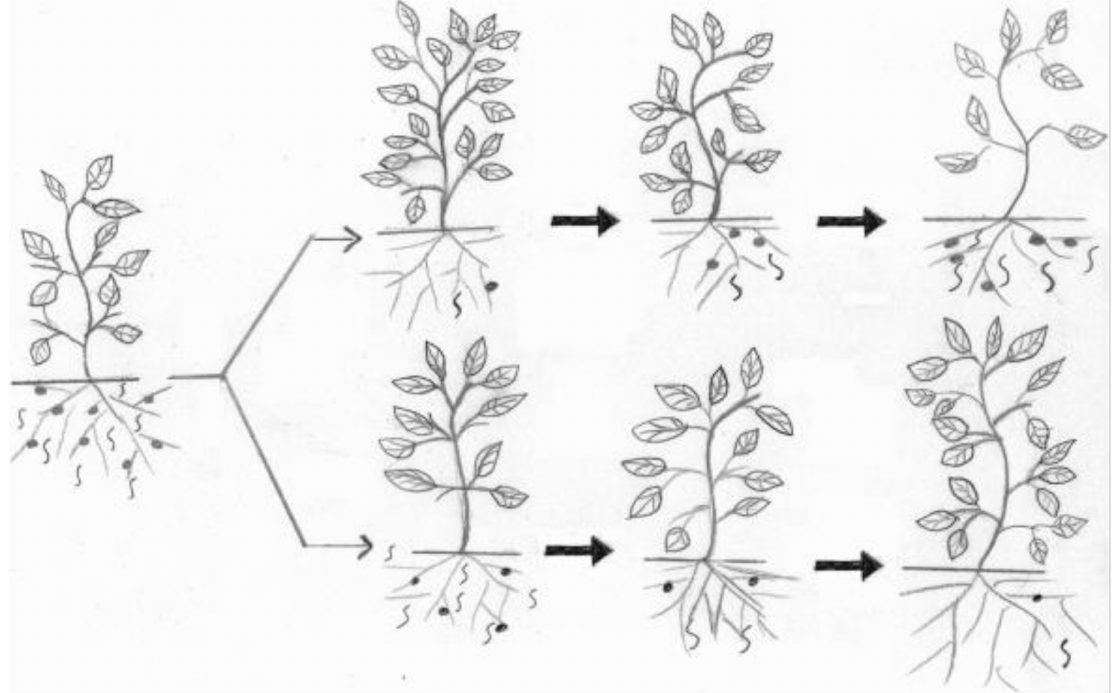
Figure 1. Effect of a chemical nematicide (upper trend) and a bionematicide (lower trend) on root-knot nematodes on susceptible plants. When both nematicides were applied, the chemical has a rapid and significant effect, reducing the nematode population. However, a few nematodes can escape its effect and reproduce to reach a damaging level, while the bionematicide can work continuously to keep the nematode below the economic threshold level